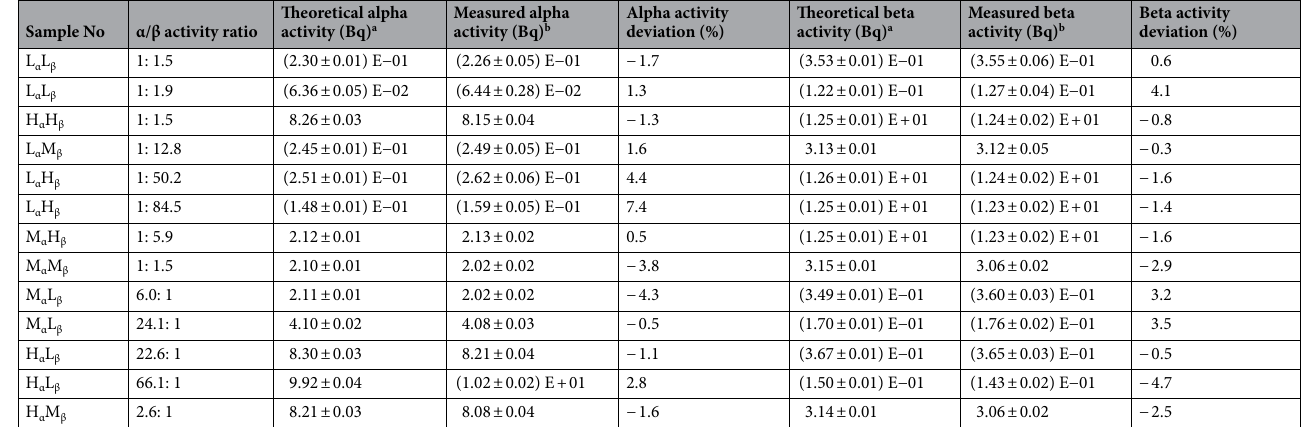
Table 5. Validation results of mixed spiked samples of 241 Am, and 90 Sr/ 90 Y standard solution (solid mass = 0). a Data obtained by multiplying the activity of the standard solution and the mass added. The expanded uncertainty corresponds to k = 1. b The expanded uncertainty corresponds to k =